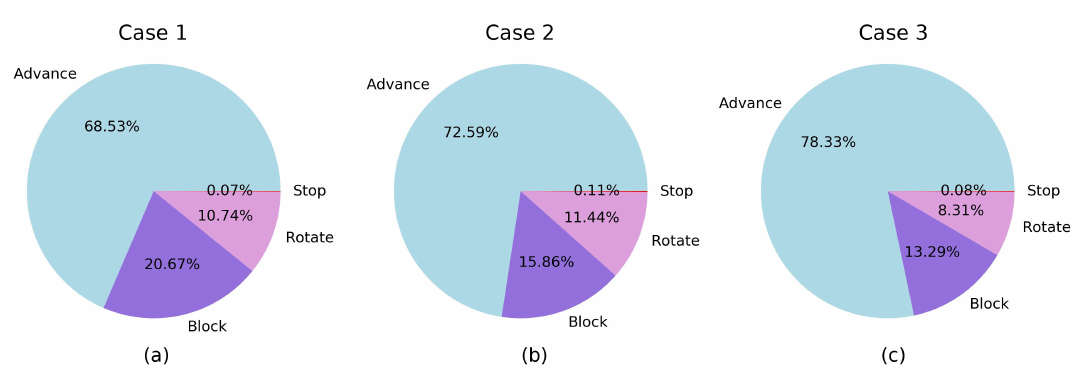
Figure 24. Relative time elapsed in each mode. ( a ) Case 1. ( b ) Case 2. ( c ) Case